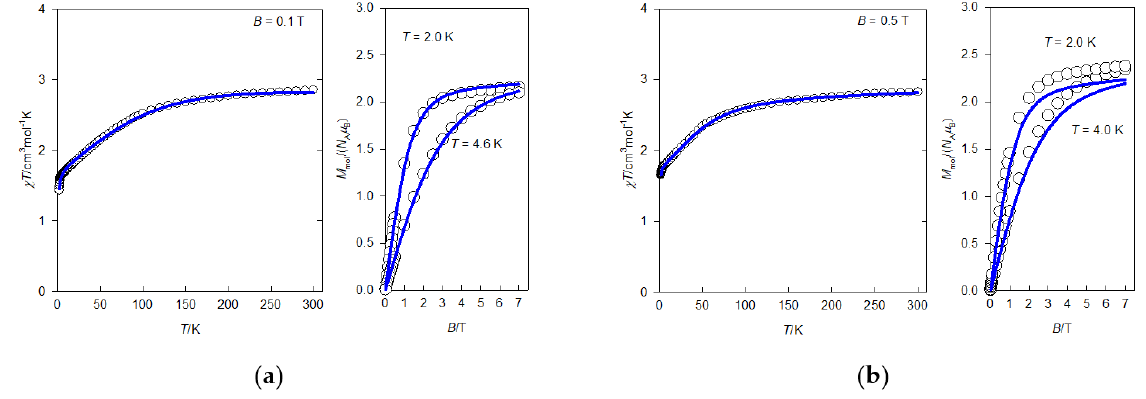
Figure 2. Product of magnetic susceptibility and temperature as a function of temperature (left) and magnetization as a function of magnetic field (right) per one magnetic centre for: ( a ) I and ( b ) II . Circles: experiment, solid line: optimum parameter fit.